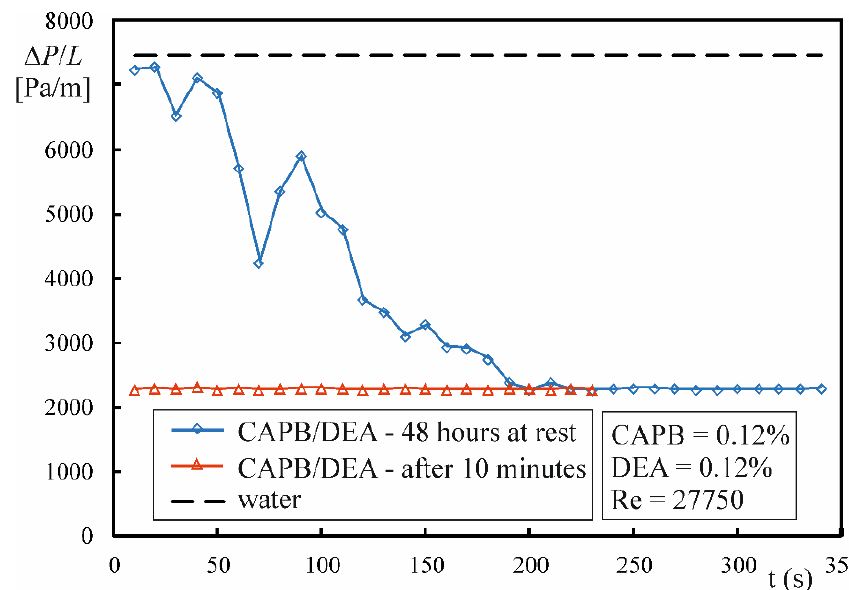
Figure 7. Image of CAPB/DEA solution, directly after sampling from the experimental set ‐ up ( a ) and after 48 h ( b ).